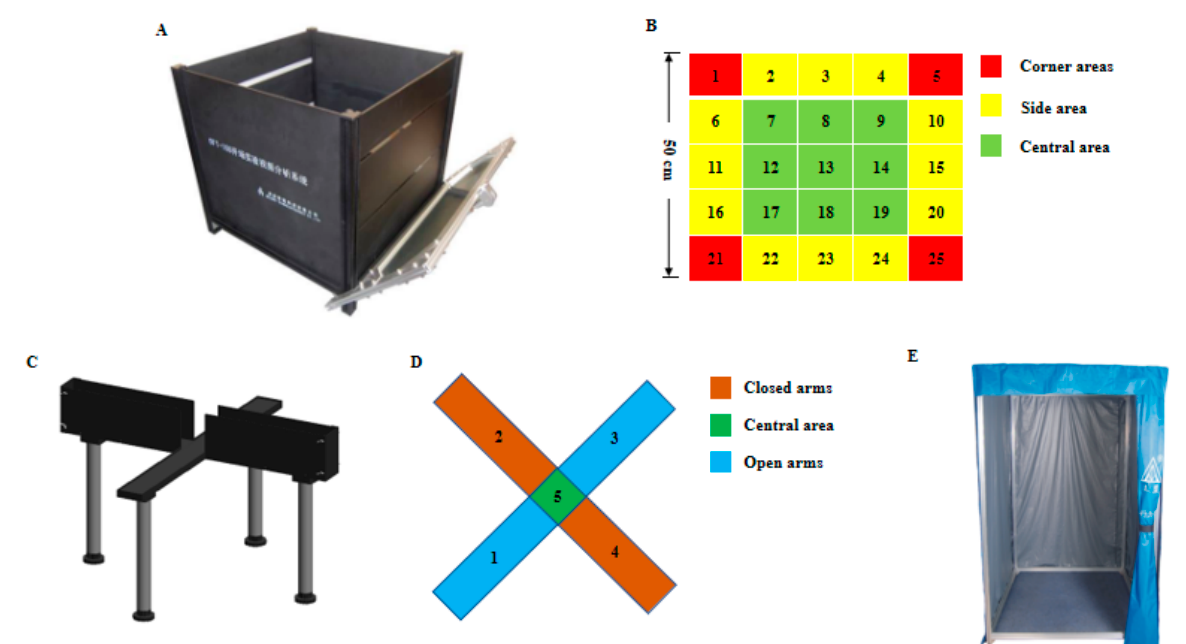
Figure 2. Behavioral test equipment. ( A , B ). Open field test device and its plane diagram. The external dimensions of the OFT box is 625 mm (length) × 740 mm (width) × 510 mm (height). The front and outer sides are equipped with reflectors. The bottom wall and surrounding side walls are made of black plastic; ( C , D ). Plus maze test device and its plane diagram. The elevated plus maze is composed of 2 open arms [300 mm (length) × 60 mm (width) × 6 mm (height)], 2 closed arms [300 mm (length) × 60 mm (width) × 150 mm (height)] and 1 central area [60 mm (length) × 60 mm (width)]. The height of the maze is 500 mm. Both the maze and the side walls of the closed arms are made of black plastic; E. The floor type test station.